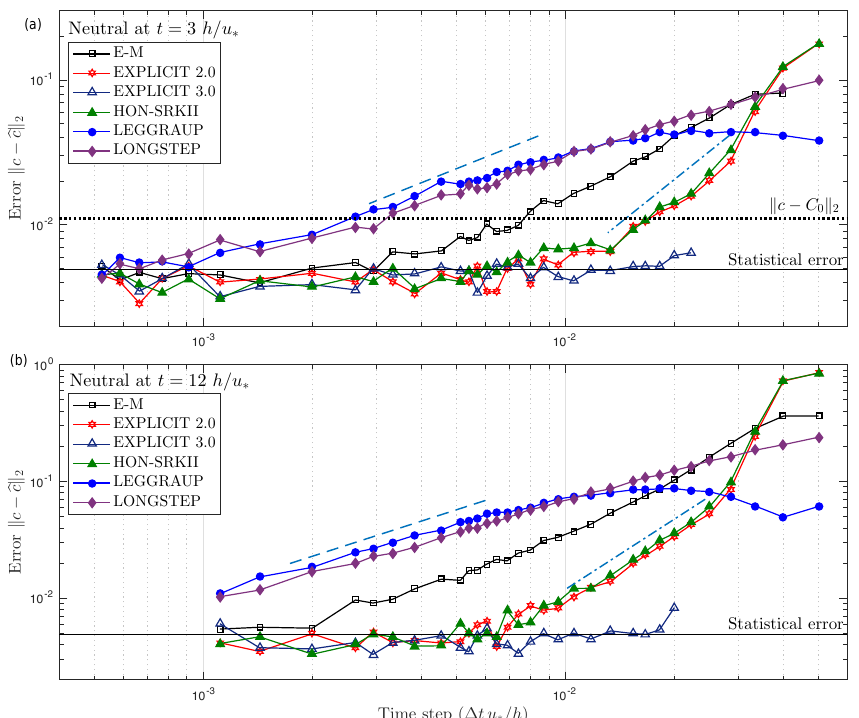
Figure 6. L 2 error (Eq. 20) as a function of non-dimensional time step (cid:49)t u ∗ /h for the neutral ABL test case integrated at intermediate time t = 3 h/u ∗ (a) and at late time t = 12 h/u ∗ (b) . From left to right, blue lines of slopes 1 and 2 are plotted for